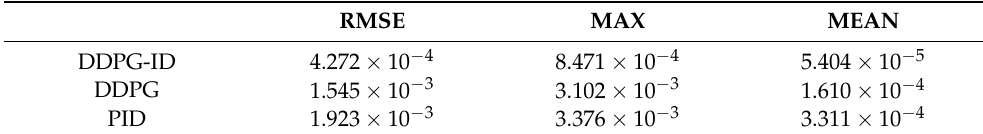
Table 7. Tracking errors comparison of different controllers in the periodic trajectory.